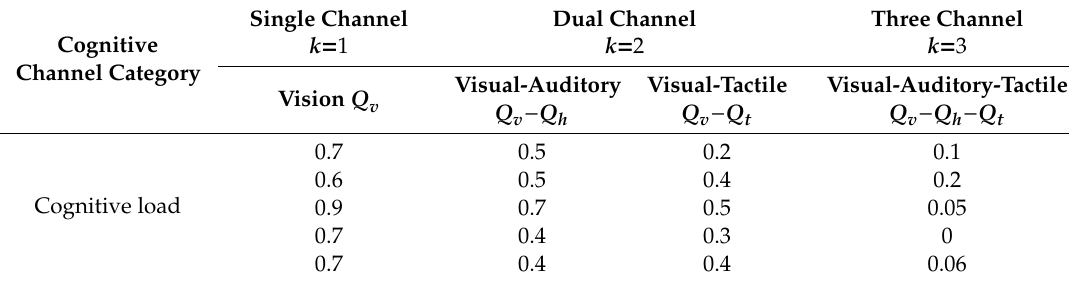
Table 6. Subjective cognitive